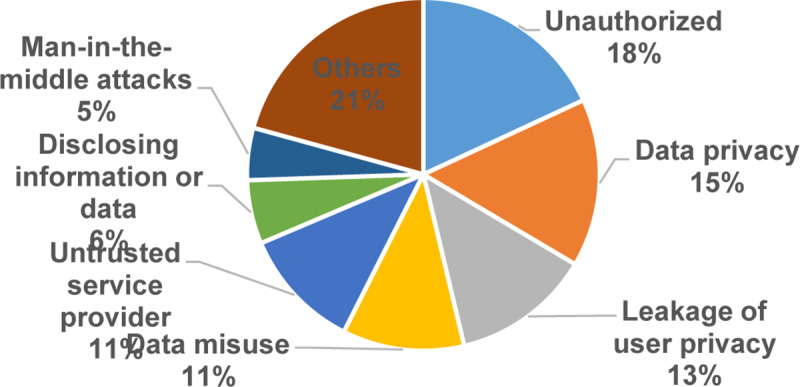
Threats and attacks.